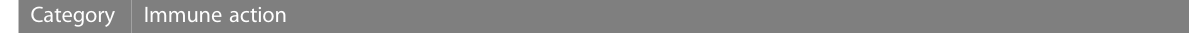
TABLE 4 Immune effects of some dietary